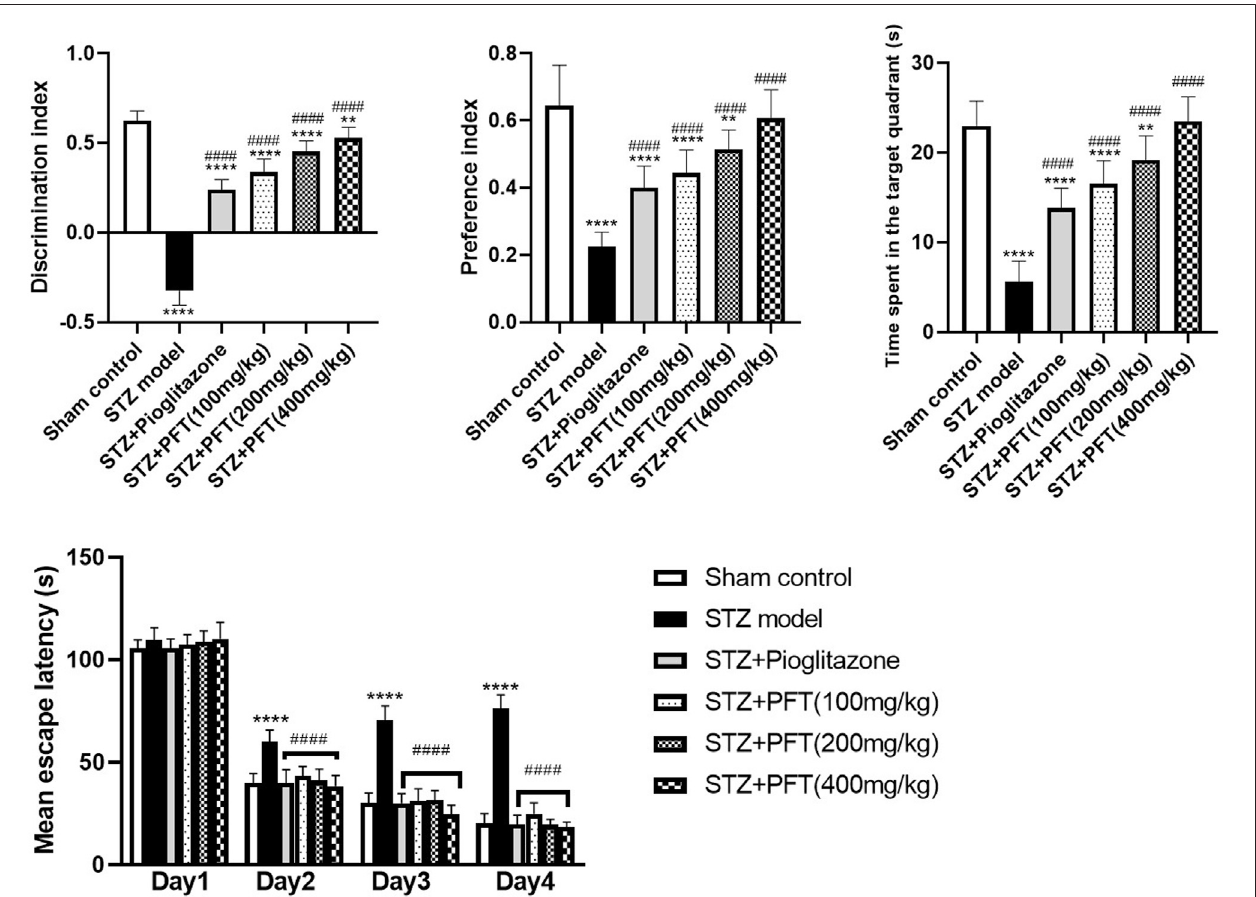
FIGURE 1 | PFT amended STZ-induced cognitive deterioration. Each bar with vertical line represents the mean ± SD of twelve mice per group; ** signi fi cantly differentfromthesham controlgroup at p < 0.01, **** signi fi cantlydifferentfrom theshamcontrol groupat p < 0.0001, #### signi fi cantlydifferentfrom theSTZgroupat p < 0.0001usingOne-WayANOVAfollowedbyTukey ’ smultiplecomparisonstest fordiscriminationindex,preferenceindexandthetime spentinthetargetquadrant,while using Two-way ANOVA for the mean escape latency.